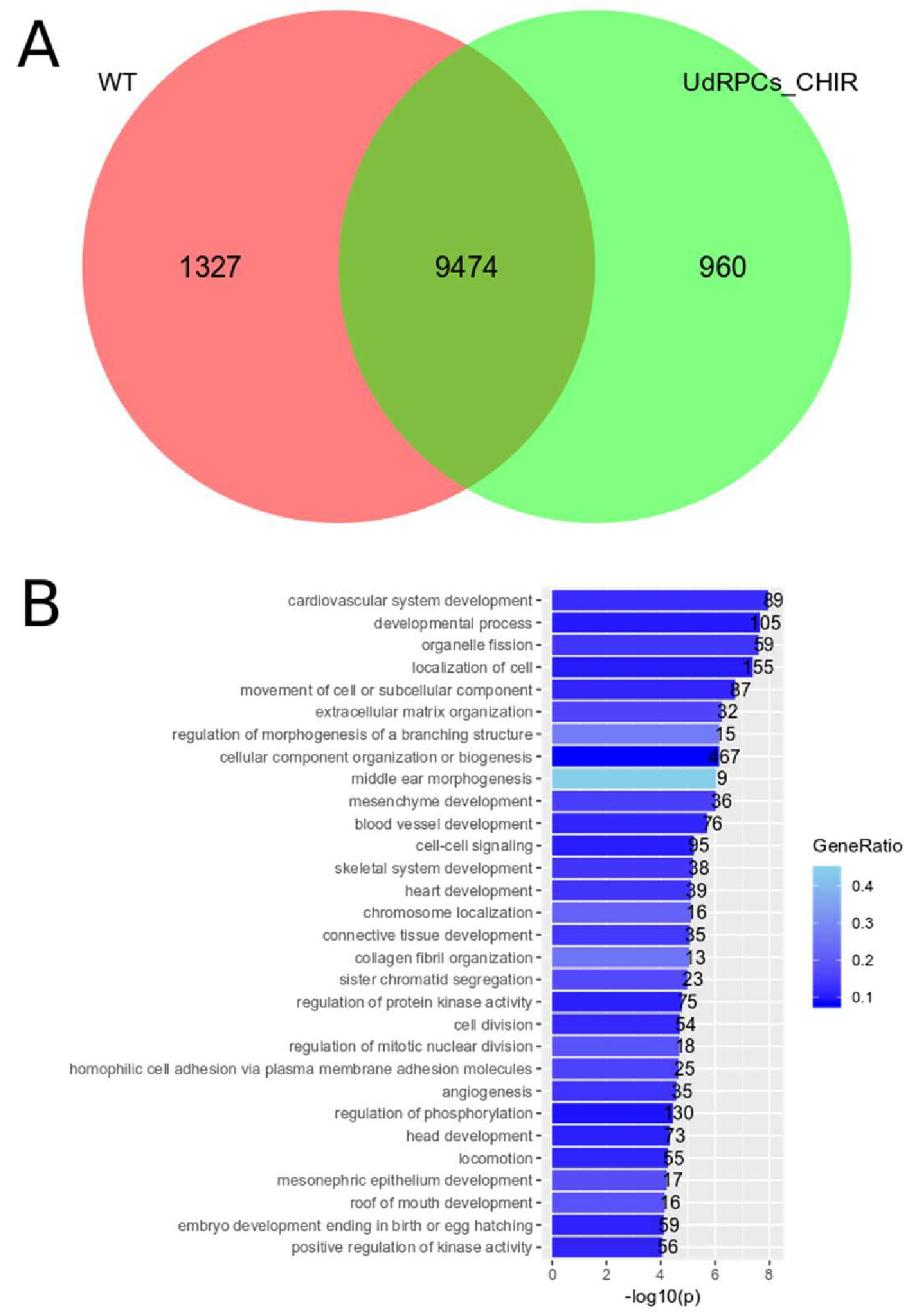
Fig 14. Comparison of Wilms cell lines with UdRPC_CHIR and analysis of the Go BP-terms of the Wilms tumor cell line exclusive gene set. A) The Venn diagram shows the overlap between genes expressed in Wilms cells (red) and UdRPC_CHIR (green) and the exclusively expressed genes. B) the 30 top Go BP-terms of the 1327 genes exclusively expressed in Wilms cells.